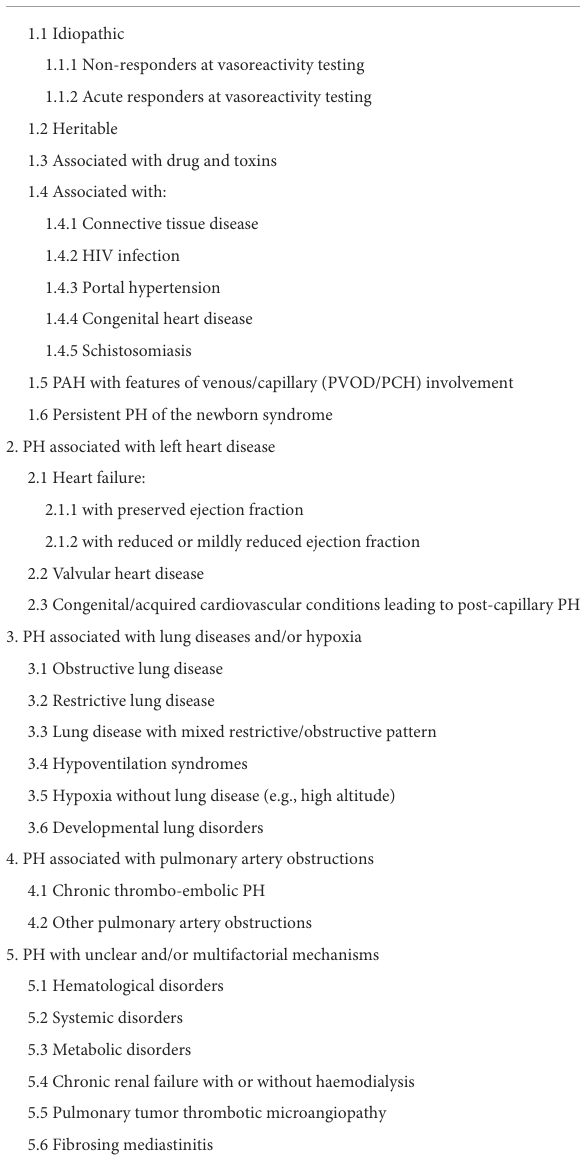
TABLE 1 Updated classification from the 2022 ESC/ERS